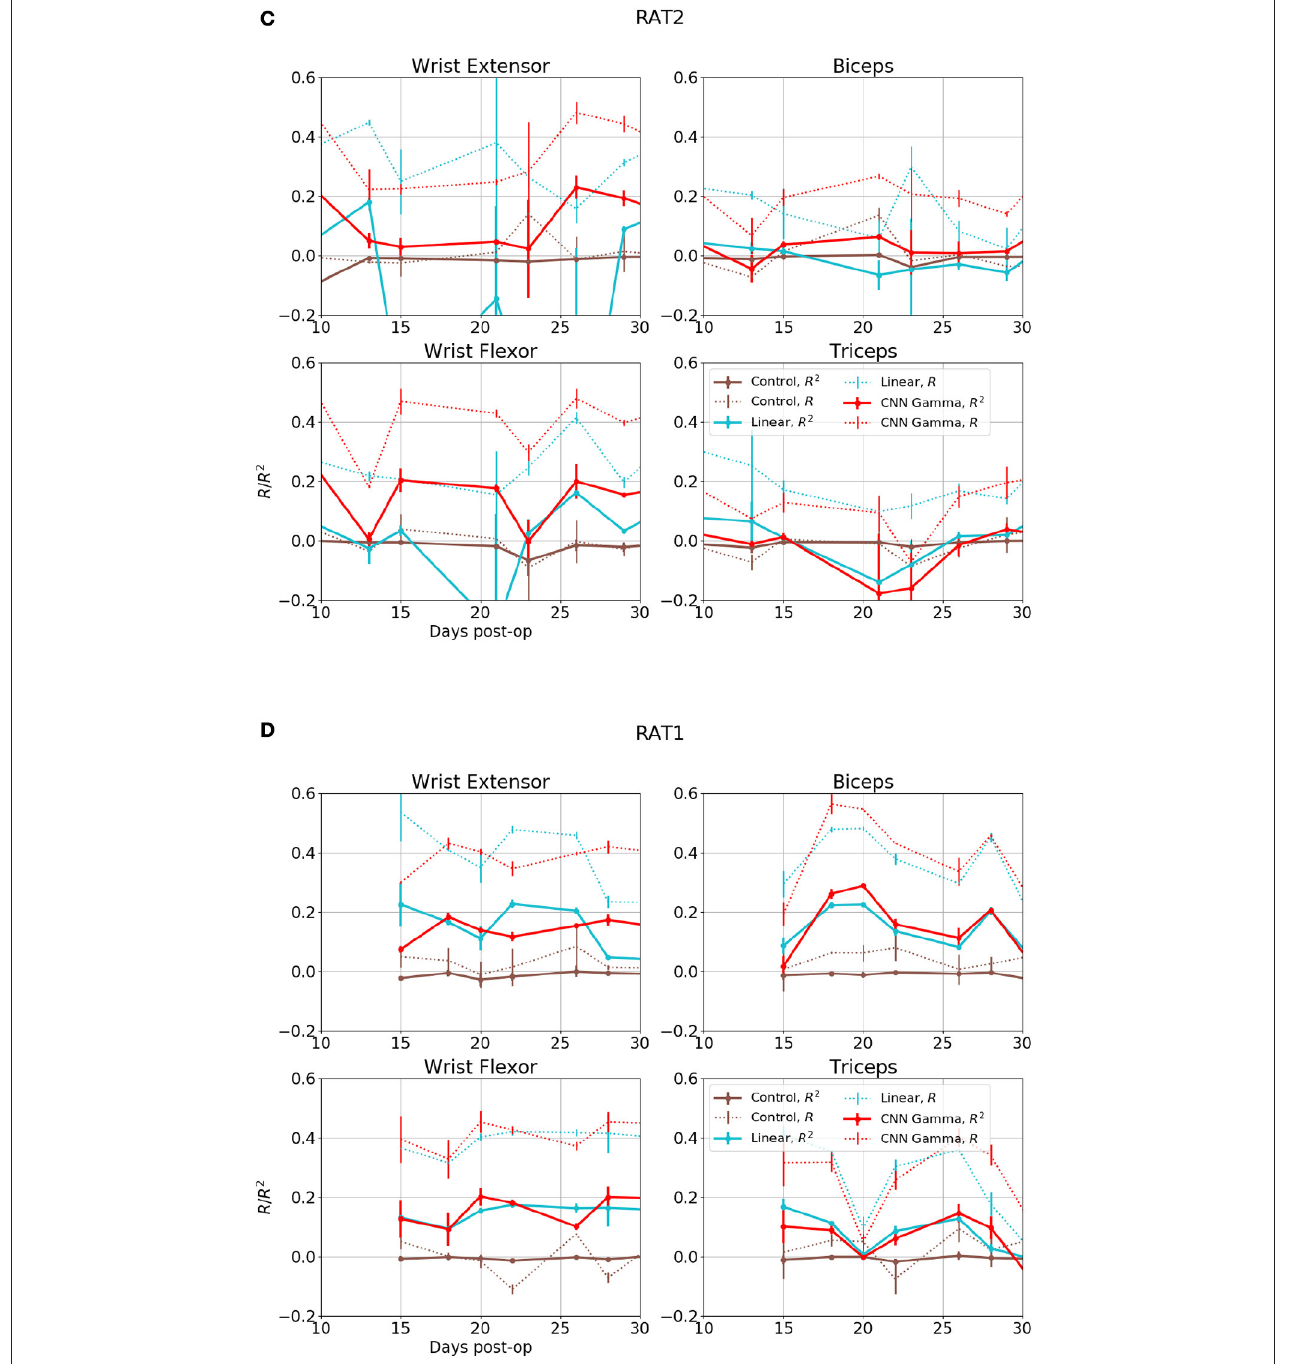
FIGURE 6 | Overall performance for four EMG signals from 4 subjects over days. X axis is the days after electrode implant. Solid lines- R 2 , Coefficient of Determination, Dashed Lines- R , Correlation Coefficients. Red: Performance of Gamma Function Networks, Cyan, Control: Linear Decoder; Brown, Control: Gamma Function Network trained on shuffled inputs. (B) Green lines shows the performance of unrestricted CNN; black arrow in indicates the data set for the plots shown in the next figure.